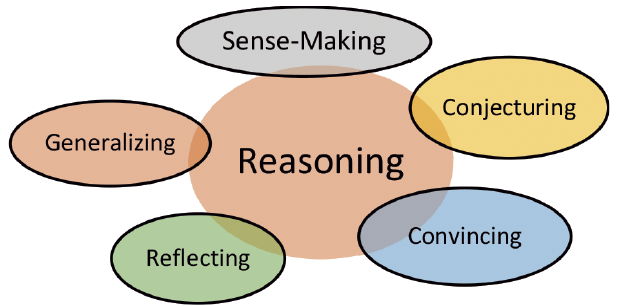
Figure 1. Reasoning Ability Indicator (Bjuland,